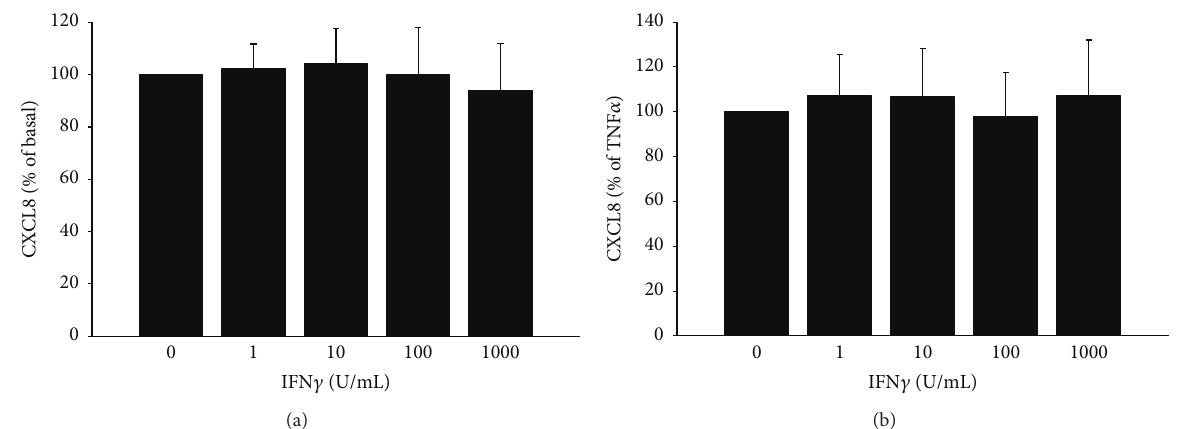
Figure 2: IFN 𝛾 does not inhibit either the basal (ANOVA F : 0.985; 𝑝 = 0.423 ) (a) or the TNF 𝛼 -stimulated (ANOVA F : 0.685; 𝑝 = 0.606 ) (b) CXCL8 secretion in TPC-1 cells. The inhibitory effect of IFN 𝛾 is expressed as percentage of basal and TNF 𝛼 -induced levels of CXCL8 which were estimated as 100%.